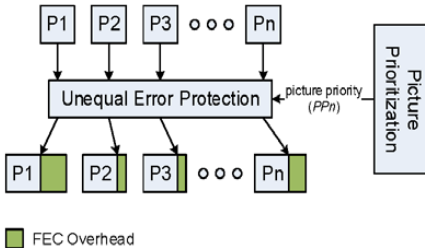
Figure 5. Unequal error protection with picture priority. PPn, picture priority.